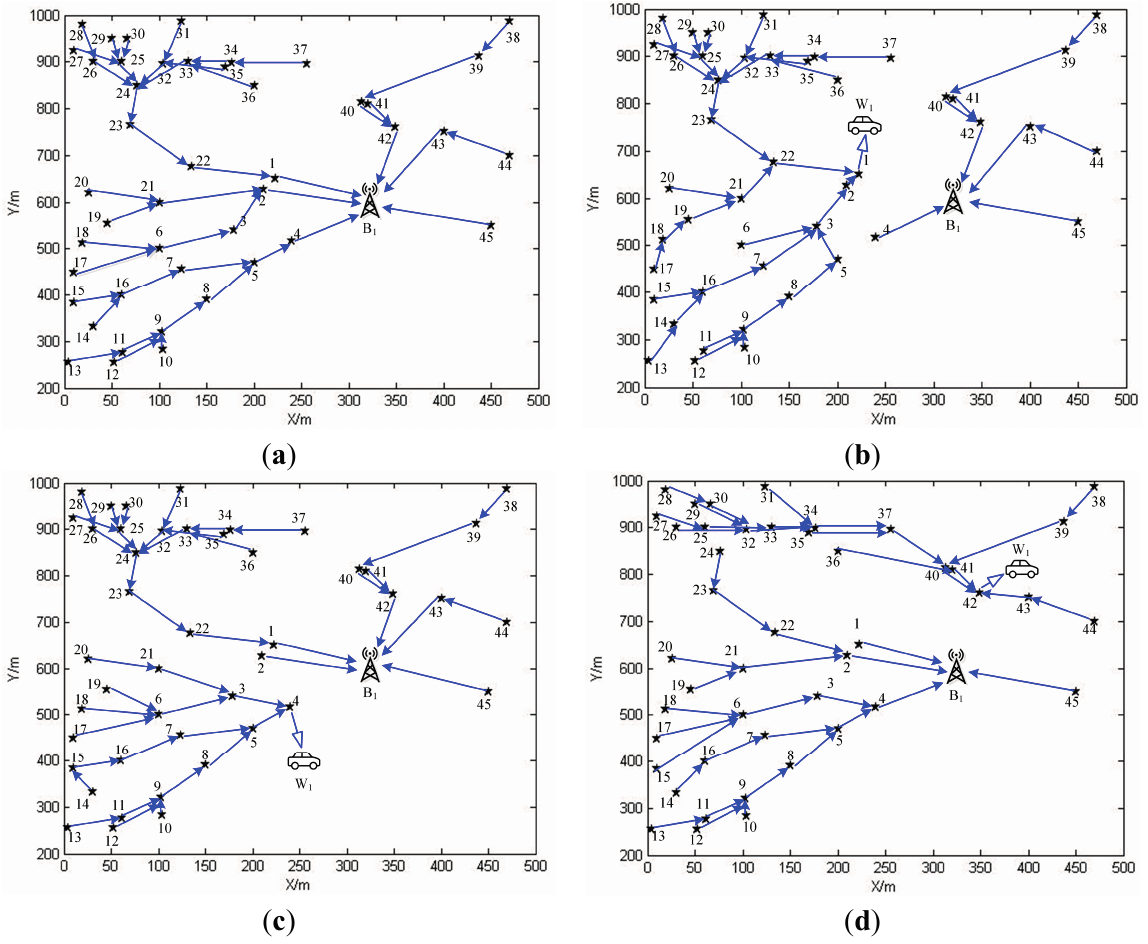
SN ; ( b ) The data routing schemes in 1